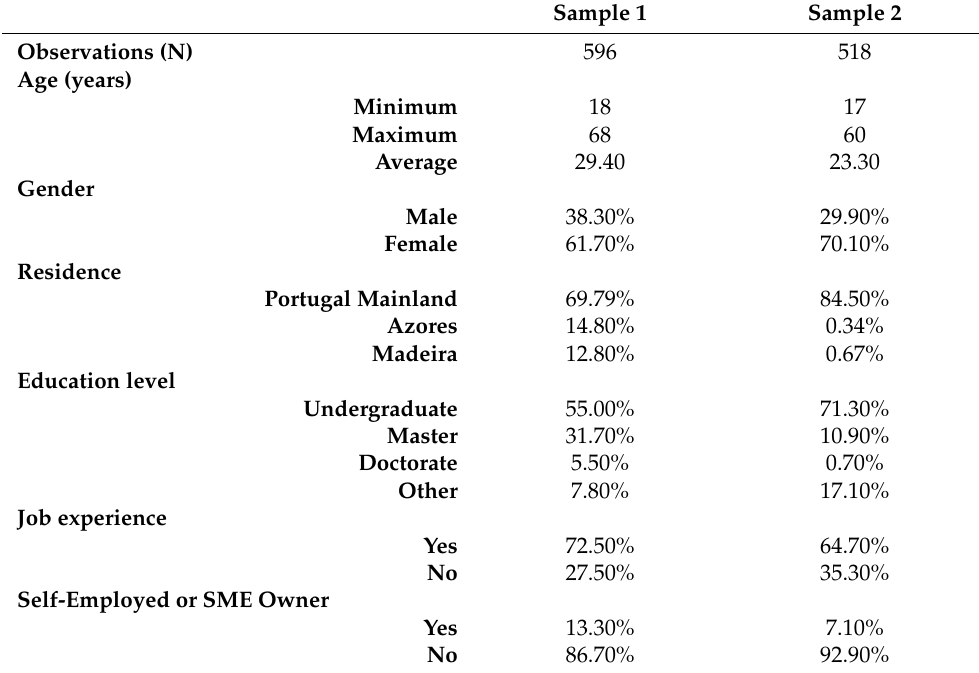
Table 2. Sociodemographic